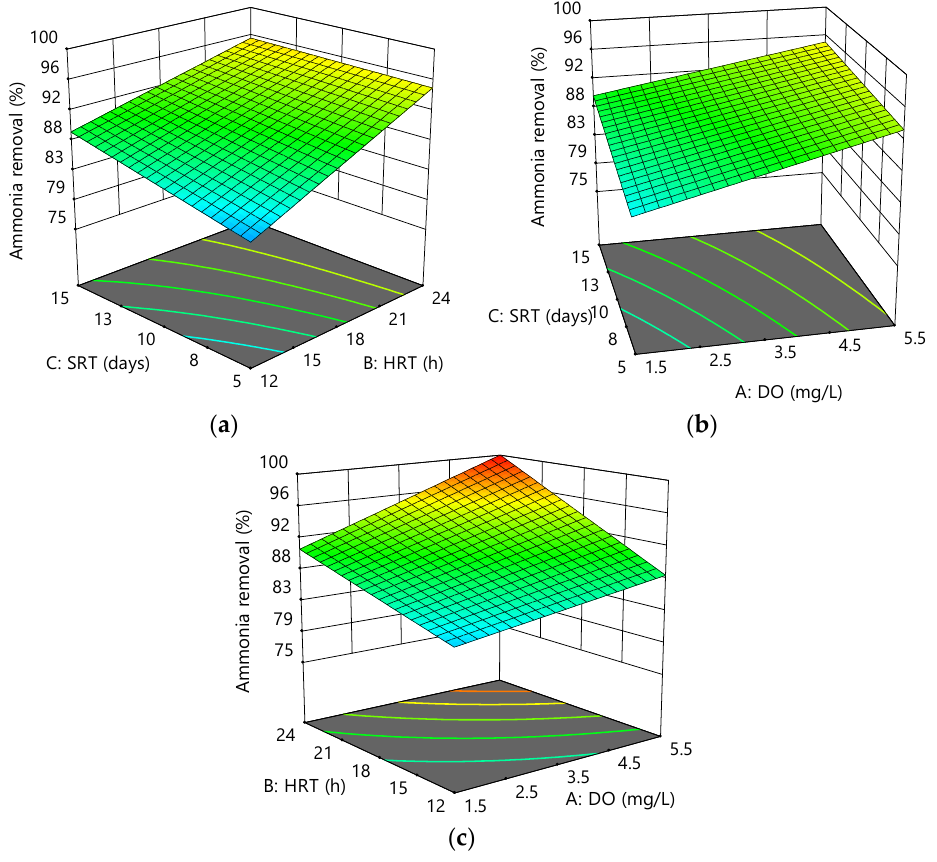
Figure 5. Response surface plots for ammonia removal efficiency as a function of the following: ( a ) HRT and DO at SRT = 10 days; ( b ) SRT and DO at HRT = 18 h; ( c ) HRT and SRT at DO = 3.5 mg/L.